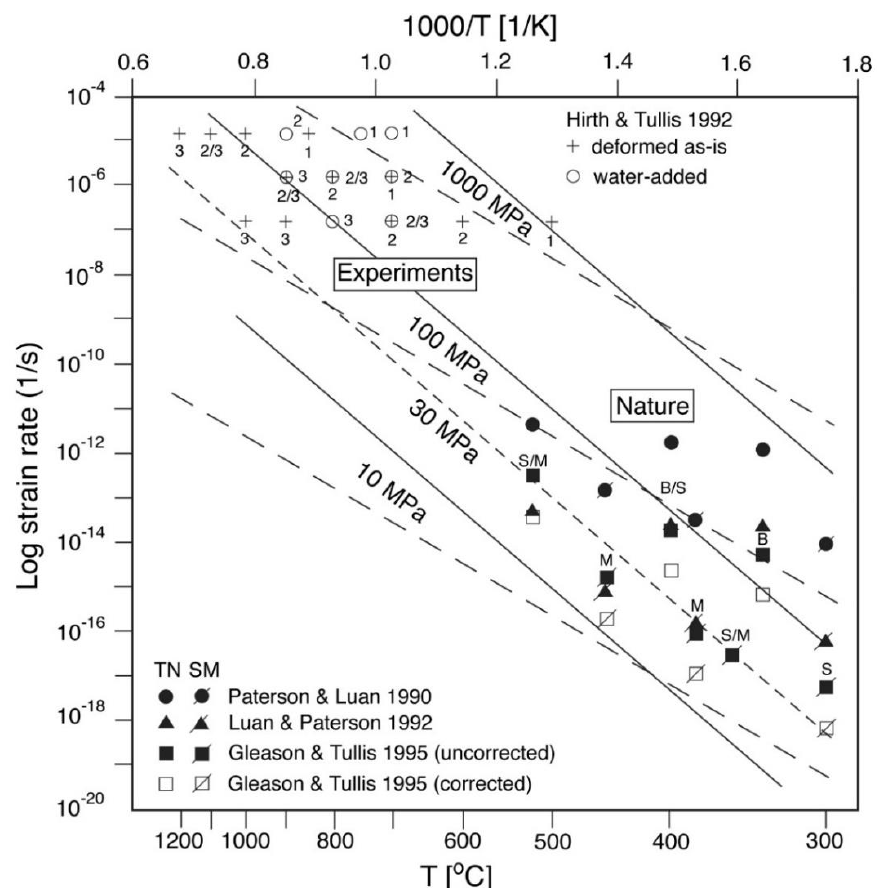
Figure 8. Plot of the logarithm of strain rate ( 𝜀̇ ) versus 1/ T showing the experimental data by [10], and natural data from the Sambagawa metamorphic rocks (this study, shown by dashed symbols below SM) and the Tonale Line (modified after [71], shown by symbols below TL). Note that in experiments by [10], some of the experiments on deformed as-is (shown by +) and water-added (shown by a circle) samples are conducted at the same physical conditions. In such cases, the symbols are superposed, and deformation regimes for experiments on deformed as-is and water-added samples are shown below and at the right of the superposed symbols, respectively. The strain rates for samples from both Sambagawa Belt and Tonale Line were calculated from the inferred differential stresses from the piezometer of [72] and assumed deformation temperatures (see text), using the flow laws of different authors (shown by different symbols). For the Sambagawa Belt, the results are shown for four representative samples (T11 at T = 300 ◦ C, 38 at T = 355 ◦ C, 35 at T = 380 ◦ C, and 18 at T = 450 ◦ C; see Figure 8 and Table 2 of [46] for the localities and numbers of each sample). The lines of constant flow stresses from the flow laws of [74,75] are shown by long-dashed and solid lines, respectively. Inferred recrystallization regimes at each of the deformation temperatures for both Sambagawa Belt and Tonale Line are shown by abbreviations: B (bulging), B/S (bulging-subgrain rotation transition), S (subgrain rotation), S/M (subgrain rotation-grain boundary migration transition), and M (grain boundary migration). Note that both natural data at the S/M transition from the Sambagawa Belt and Tonale Line, and the experimental data at regime 3 roughly lie on the iso-stress line of 30 MPa calculated from the flow law of [75]. Modified after Figure 8 of [71], but the flow law of [75] was not modified, as conducted in [71]. See text for further